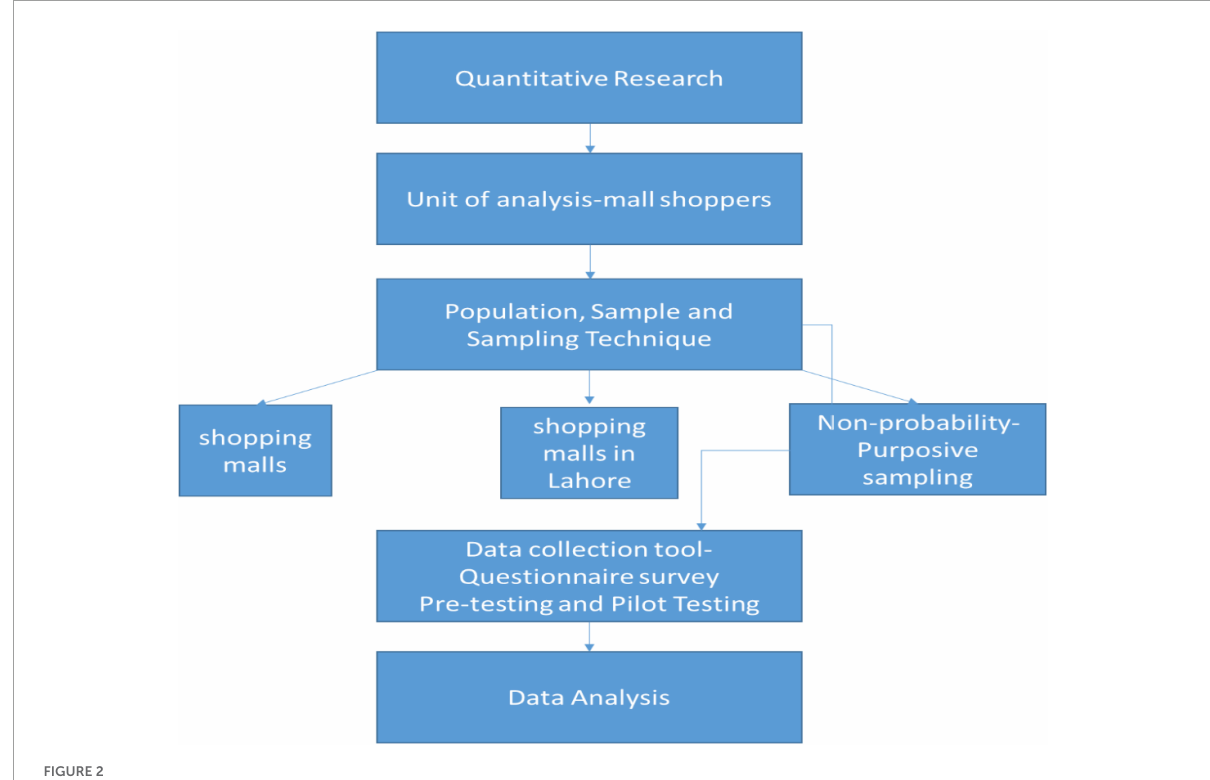
FIGURE2 Research